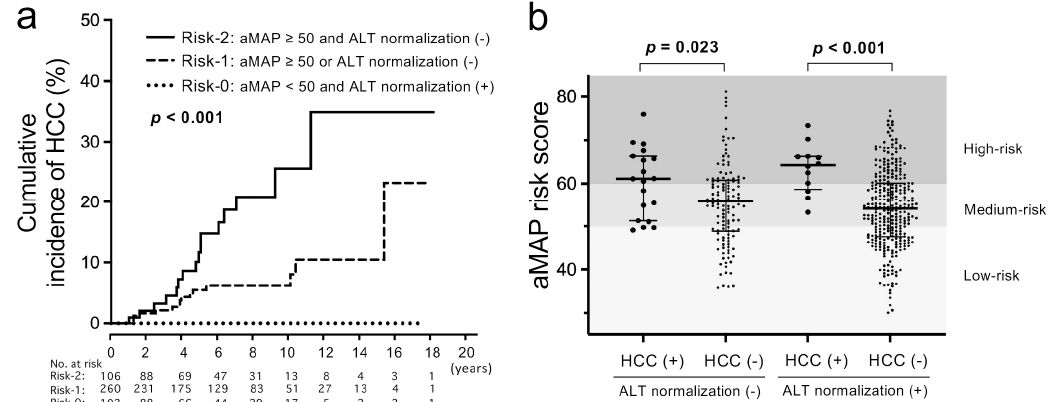
Figure 3. Analyses of cumulative incidences of HCC according to both baseline aMAP risk scores and 1-year ALT normalization of JSH criteria. ( a ) Comparison of cumulative incidences of HCC between the risk-0 group (aMAP risk score < 50 and ALT normalization), the risk-1 group (aMAP risk score ≥ 50 or no ALT normalization) and the risk-2 group (aMAP risk score ≥ 50 and no ALT normalization). ( b ) Distribution of aMAP risk scores in patients with and without ALT normalization at 1 year of NA therapies and with and without HCC development.